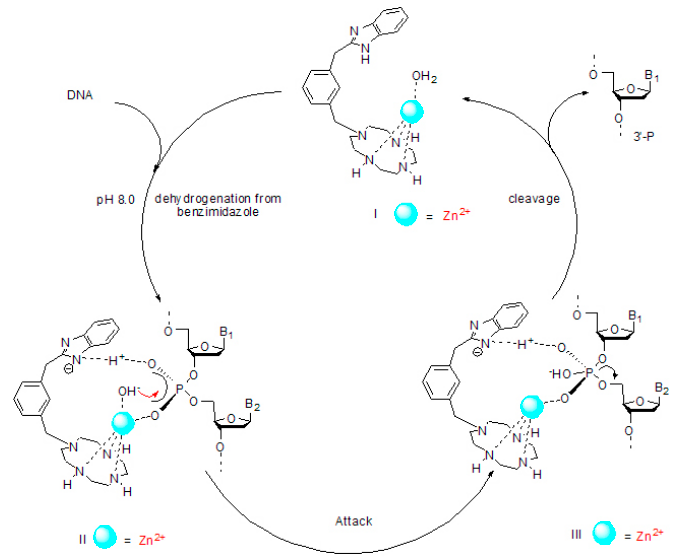
Scheme 2. Possible mechanism of DNA cleavage catalyzed by the complex 1a .